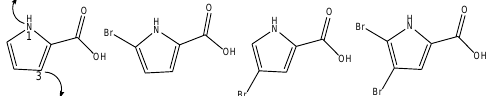
nucleophilic positions (N-1 and C-3) (Al- Mourabit and Potier, 2001) To explain the high structure diversity of this compound group members, Al Mourabit and Potier (2001) proposed different intra molecular cyclization mechanisms. Positions N- 1 and C-3 of the pyrrole part participate in intramolecular cyclizations (Figure 6) (Al Mourabit and Potier, 2001), while position C-2, which is the most nucleophilic in a free pyrrole has only rarely been quaternized (Hoffmann and Lindel, 2003). Among the simple heterocycles, free or N -methylated pyrrole which nucleophilic solvents Hoffmann and Lindel, 2003).